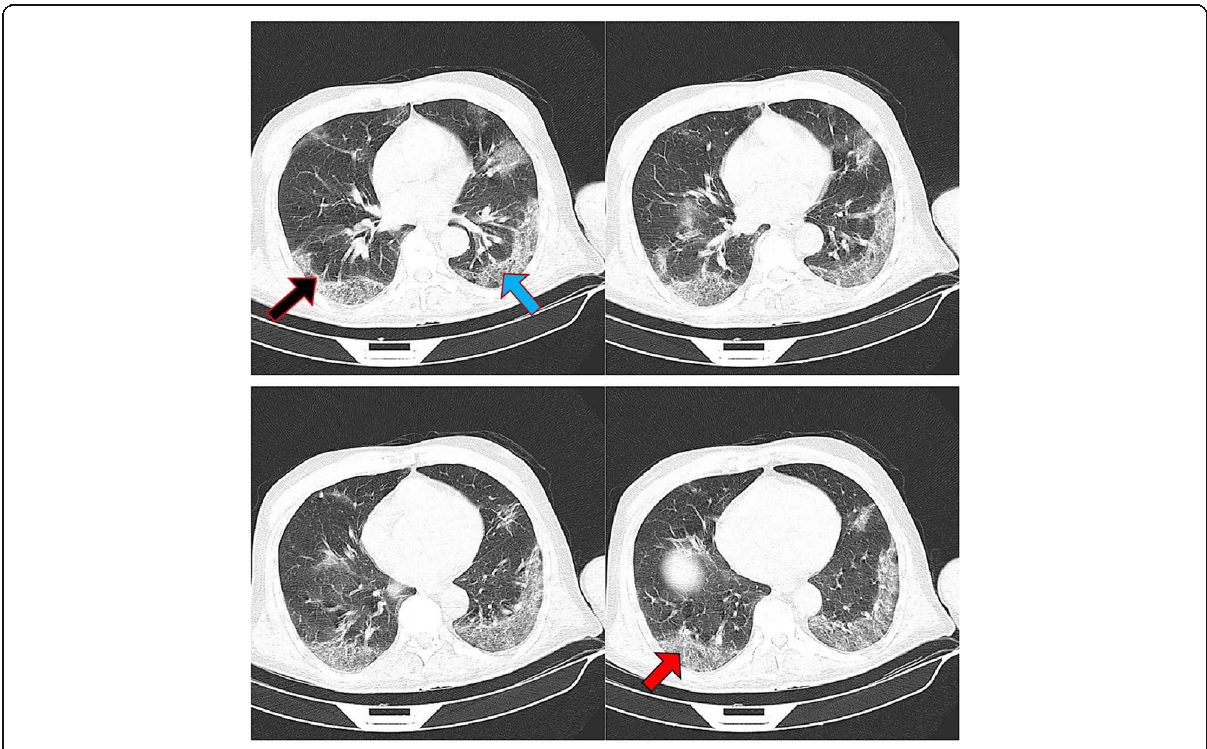
Fig. 1 A 77-year-old male patient presented with fever, chills, and dry cough, who was admitted to the regular ward and was discharged on day 10 of admission. Peripheral multilobar ground glass opacities (red arrow), parenchymal bands (black arrow), and crazy paving (blue arrow) are observed in the CT scan. The total CT severity score was calculated as 15, and the disease severity was